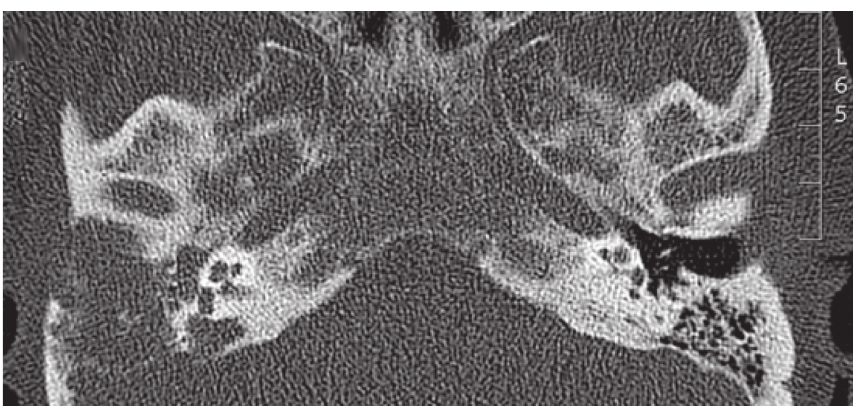
Figure 1: Axial view of the initial temporal CTshowed complete opacification of the external auditory canal, middle ear, and mastoid on the right side indicating a soft tissue mass.